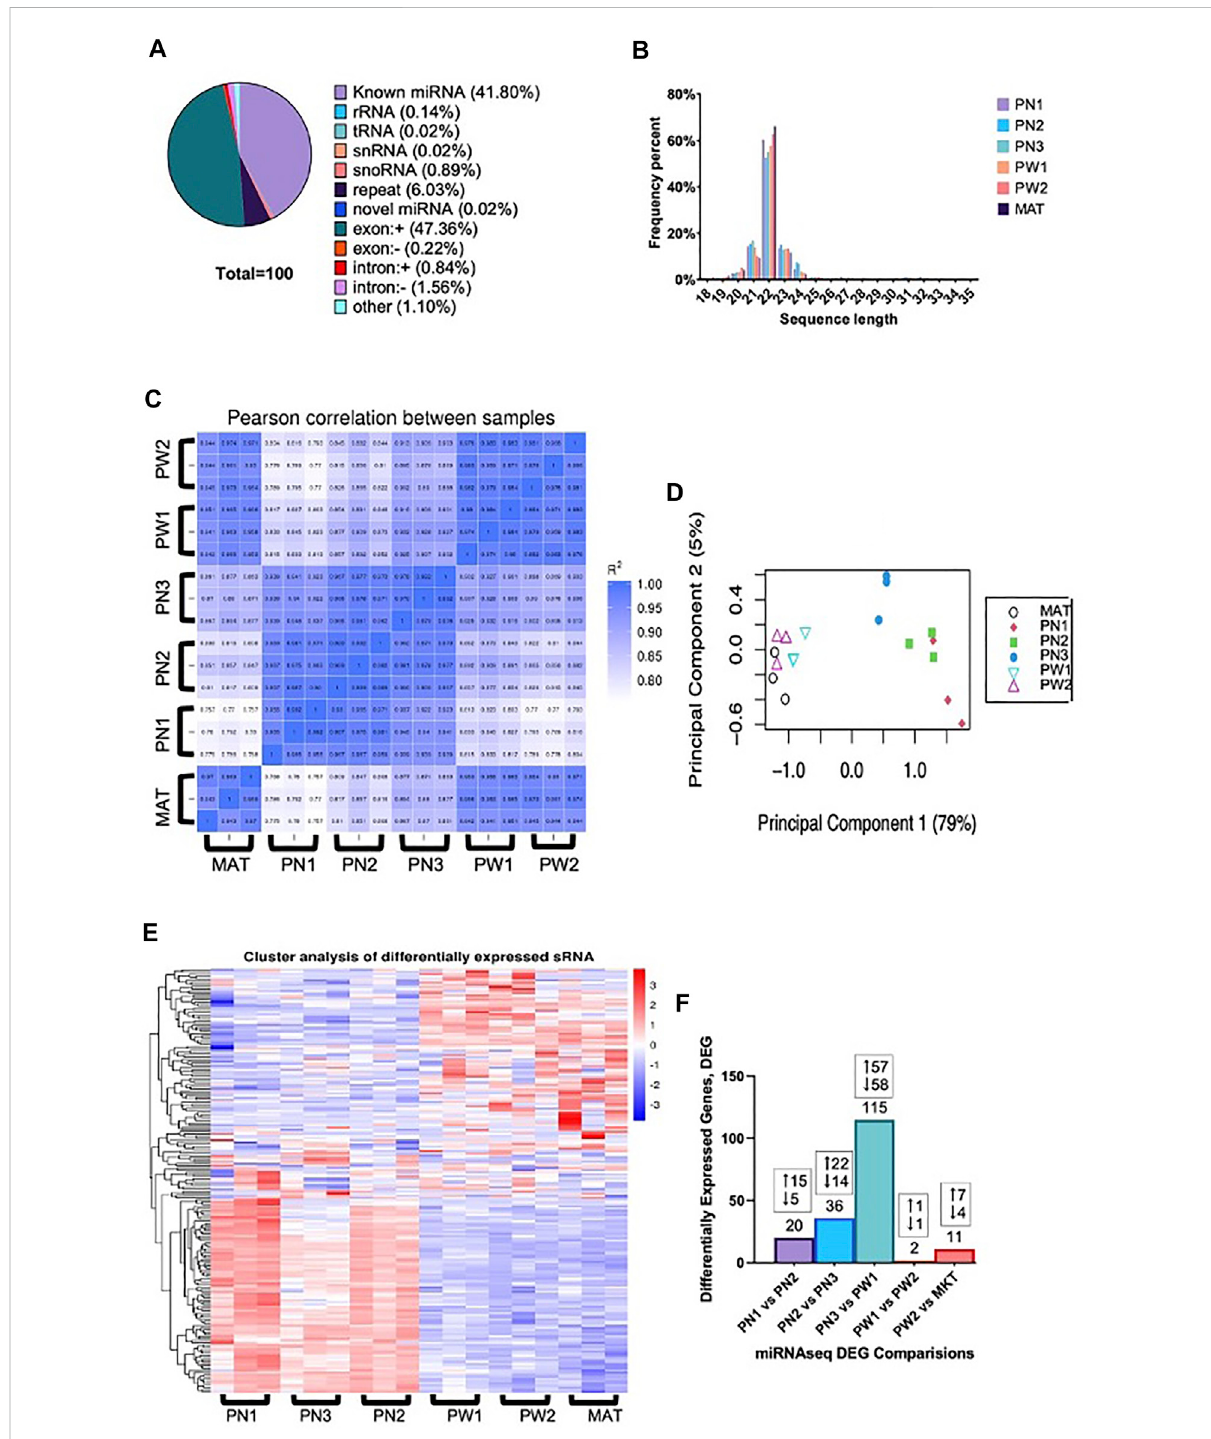
FIGURE 2 Small RNA analysis of ovine skeletal muscle at 6 developmental time points. (A) The classi fi cation of small RNA reads. (B) Distribution of small RNA sequence lengths from six developmental time points. (C) Correlation heat map of individual samples within developmental timepoints. (D) Principalcomponentanalysisofindividualsamples. (E) Hierarchicalclusteringanalysisofindividualsampleswithineachdevelopmentaltimepoint. (F) Number of differentially expressed miRNA from each comparison made with the number of up and downregulated miRNA